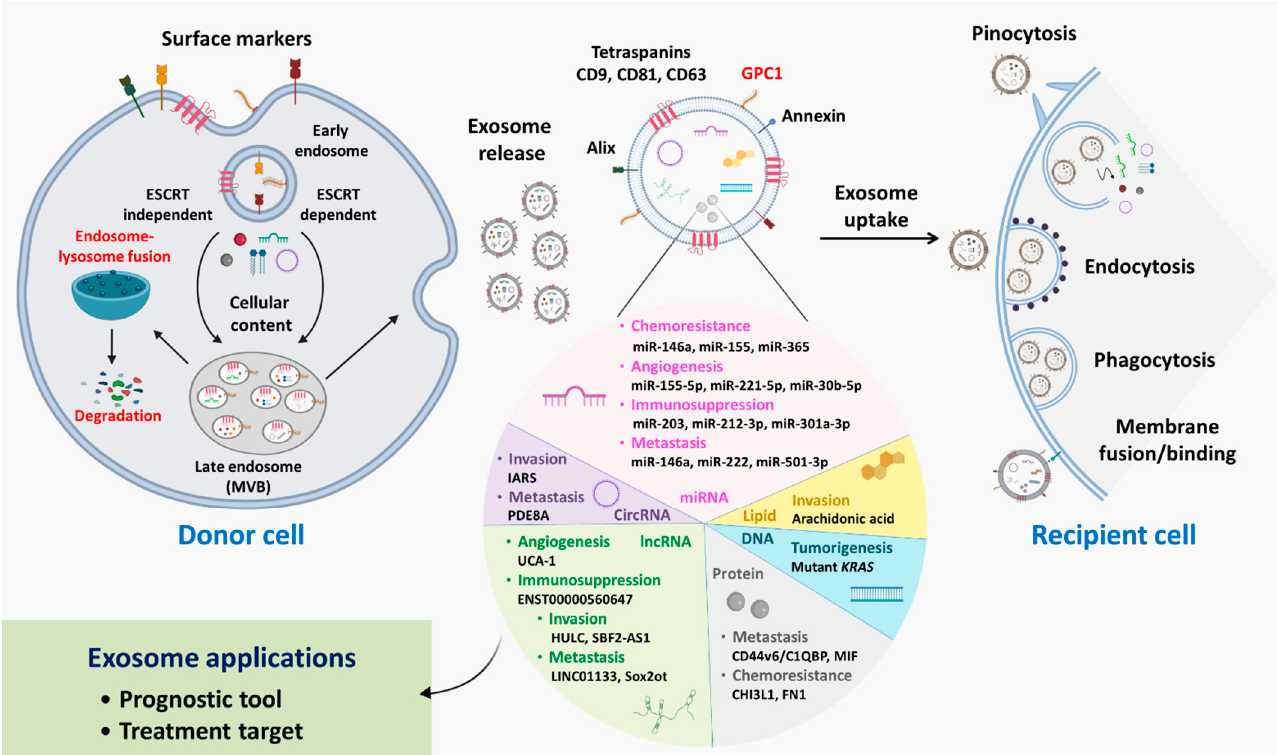
Figure 1. Insights into exosome biogenesis, cargo packaging, and cellular uptake. Inward budding of the cellular membrane facilitates early endosome formation; during this process, cell surface markers/receptors are loaded within endosomal bodies, which are later present on the exosomal surface. During maturation, cellular contents, including proteins, lipids, DNA, circRNAs, miRNAs, lncRNAs, and mRNAs, are loaded into endosomes by ESCRT-dependent or ESCRT-independent mechanisms, forming late endosomes/MVBs. Late endosomes may undergo recycling following fusion with lysosomes, degrading endosomal contents; otherwise, late endosomes are moved to the cell membrane, resulting in membrane fusion and exosome release from cells. Exosomal entry into recipient cells is directed by one of several mechanisms, such as pinocytosis, endocytosis, phagocytosis, and membrane binding/fusion, depending on the cellular receptors and exosomal surface molecules present. Exosomal cargos and their effects on PDAC progression are summarized in the pie chart. Overall, evaluation of exosomal contents may be used in clinical applications for disease prognosis prediction, and exosomes may be employed as antagonist delivery systems for treatment.